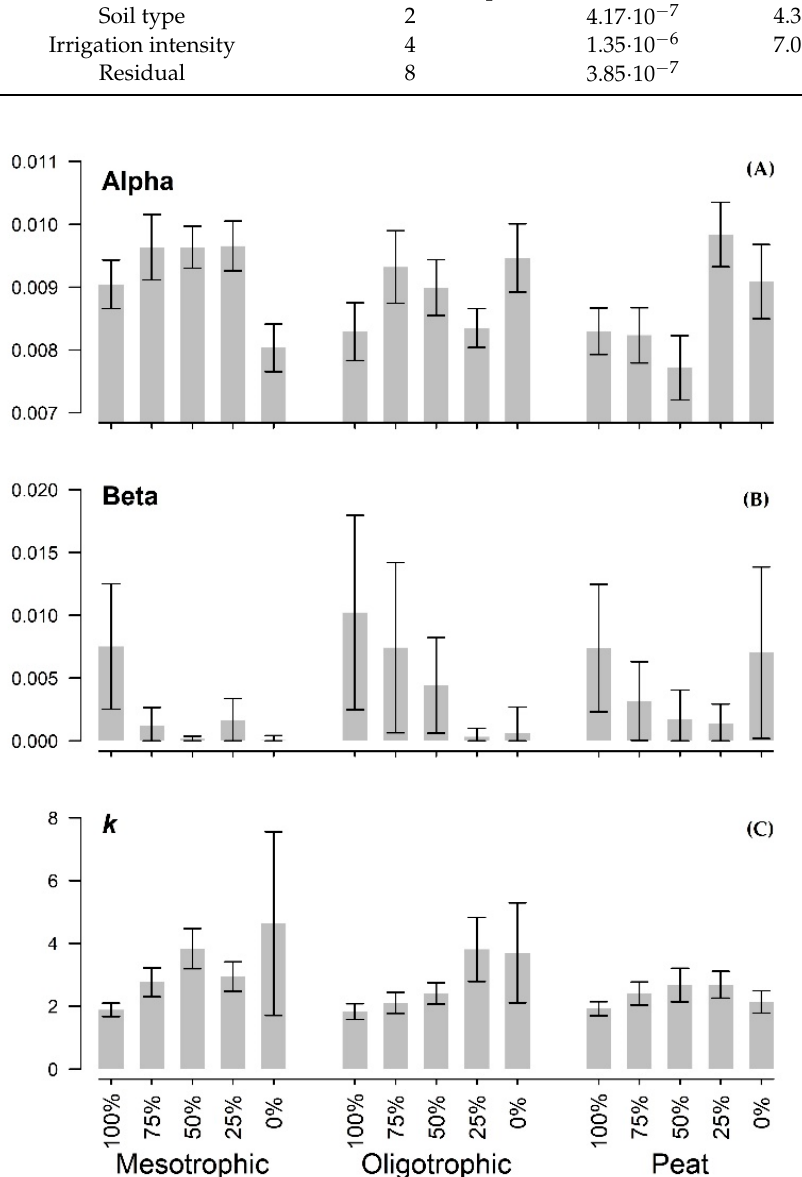
Figure 3. The asymptote (alpha) ( A ), displacement (beta) ( B ), and growth rate ( k ) ( C ) parameters